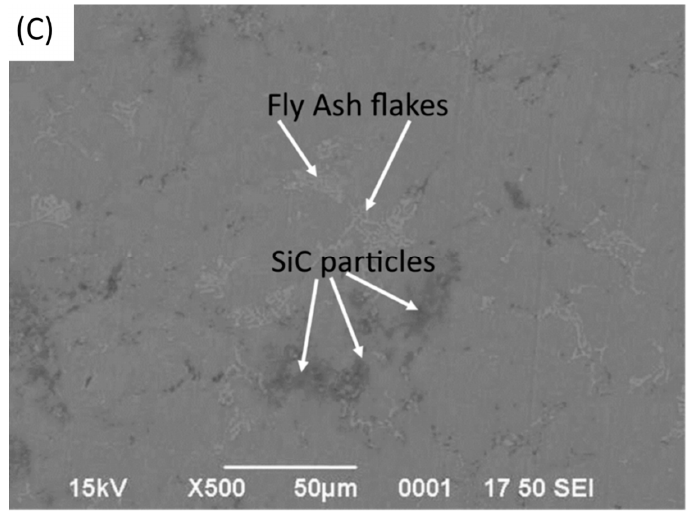
Figure 5. SEM image depicting the distribution in ( a ) AA 5083/5 wt.% SiC/2 wt.% fly ash, ( b ) AA 5083/5 wt.% SiC/4 wt.% fly ash, and ( c ) AA 5083/5 wt.% SiC/6 wt.% fly ash composites.